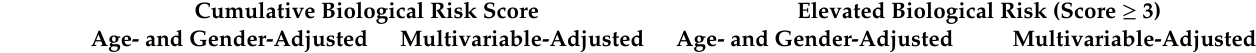
Table 3. Associations between household food security and cumulative biological risk: National Health and Nutrition Examination Surveys